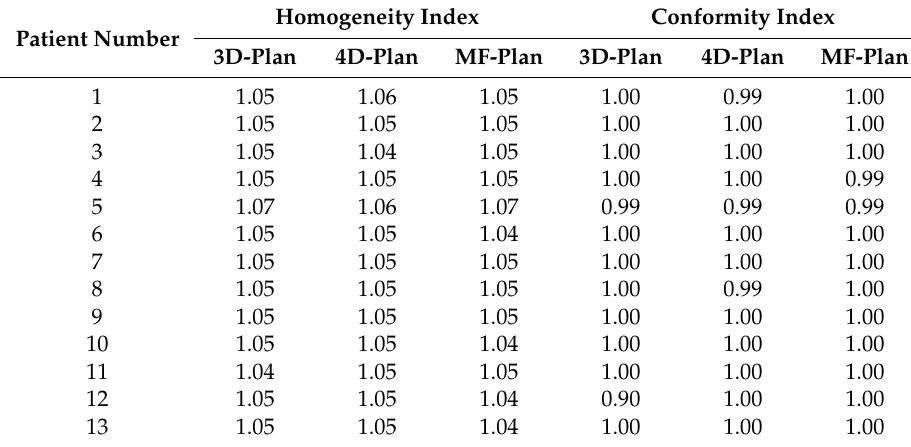
Table 6. Homogeneity index (HI) and conformity index (CI) of individual patients under different treatment plans.